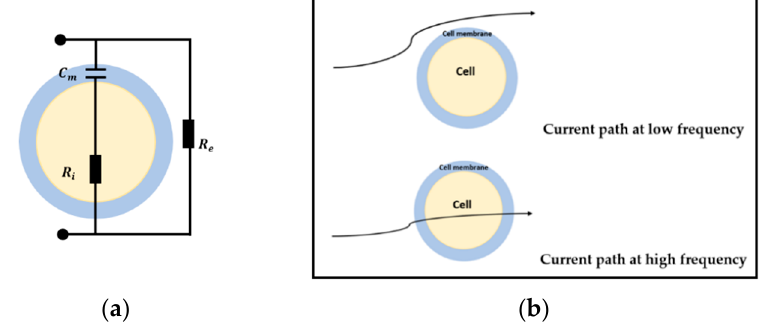
Figure 1. ( a ) Fricke circuit. ( b ) Current path at different excitation frequency.